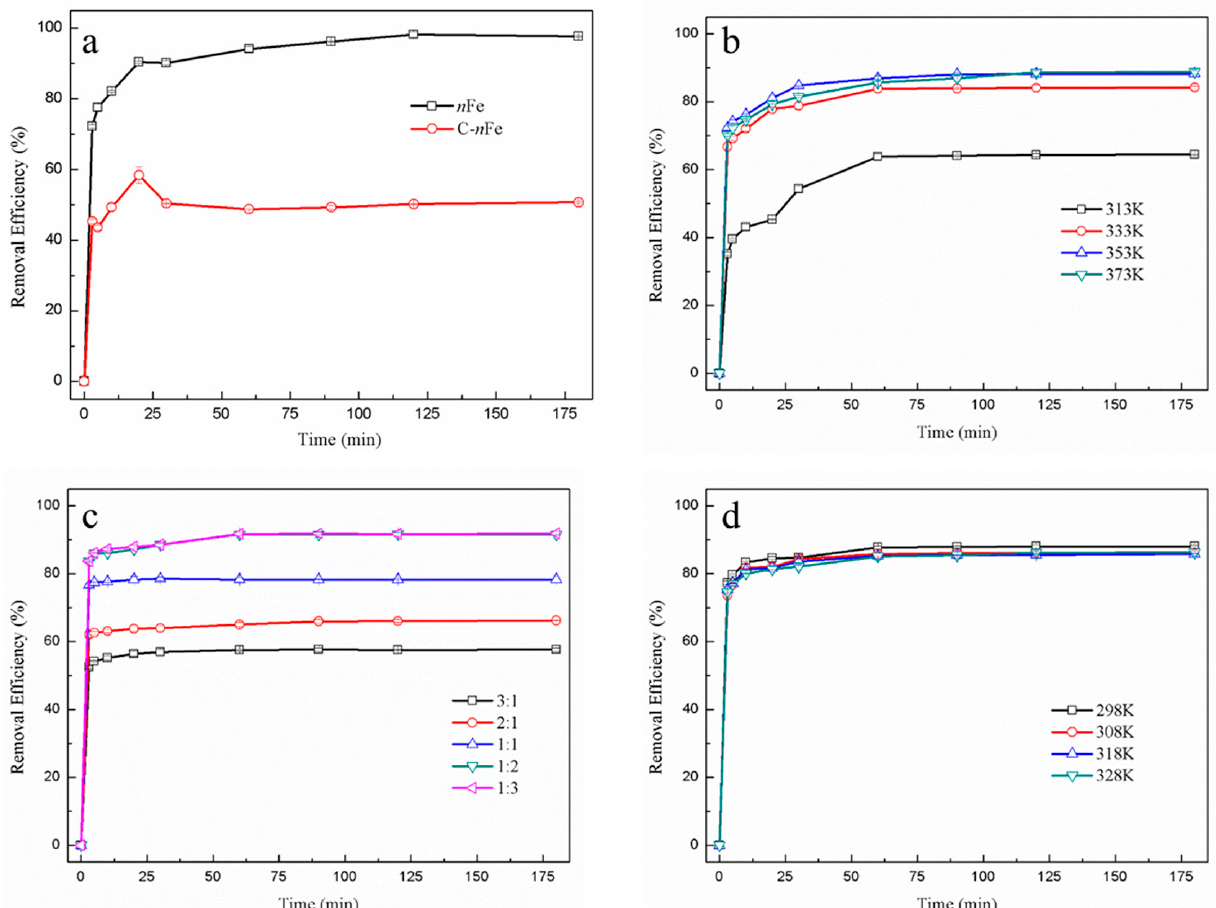
Figure 1. Temporal variation in Cr(VI) removal efficiency for green synthesized n Fe (black line) and commercially purchased n Fe (C- n Fe) (red line) ( a ) with different synthesis conditions, including green tea extract water bath temperature (313, 333, 353, and 373 K) ( b ); the ratio of GT:Fe 2+ (3:1, 2:1, 1:1, 1:2, and 1:3) ( c ); synthesis temperature (298, 308, 318, and 328 K) ( d